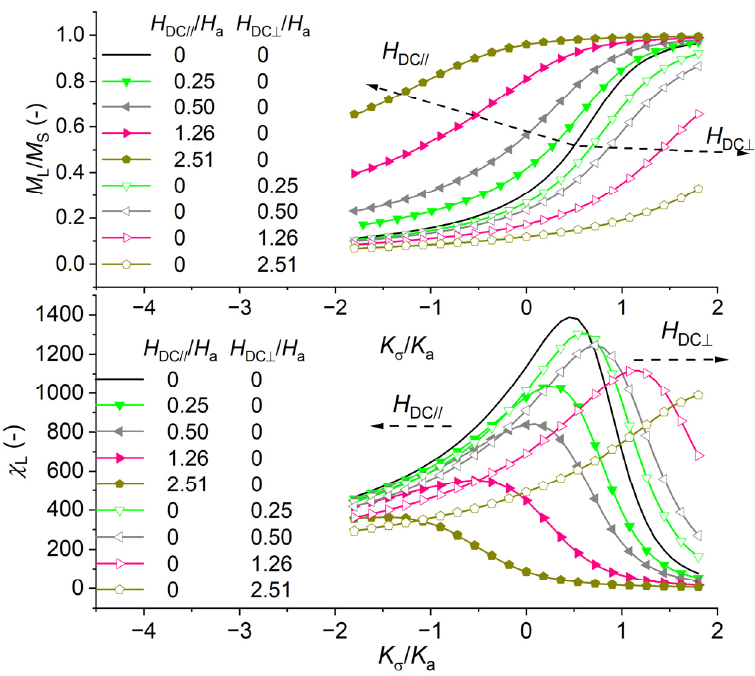
Figure A4. Relative longitudinal magnetization component ( M L / M S ) versus stress for different for different applied field (top) and corresponding relative longitudinal susceptibility component χ L versus stress for different for different applied field (bottom).